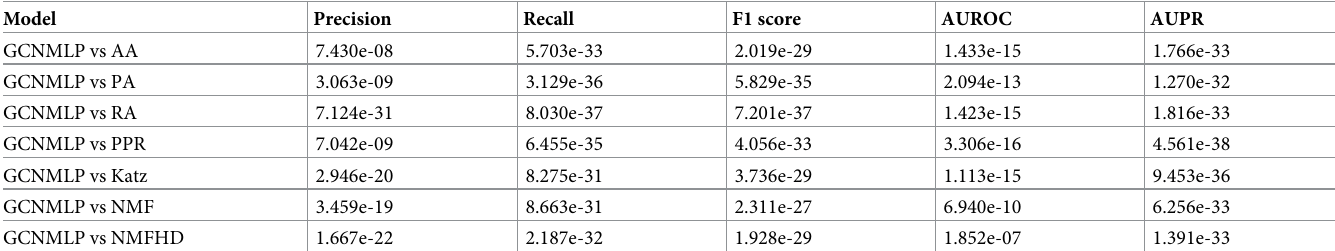
Table 8. Comparing the p-value of the t-test among the GCNMLP and various algorithms.